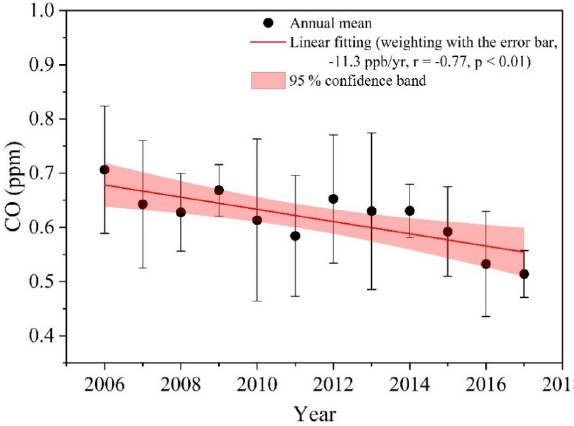
Figure 6. Frequency distribution of the CO mixing ratios and Lorentz curve fitting results for different time